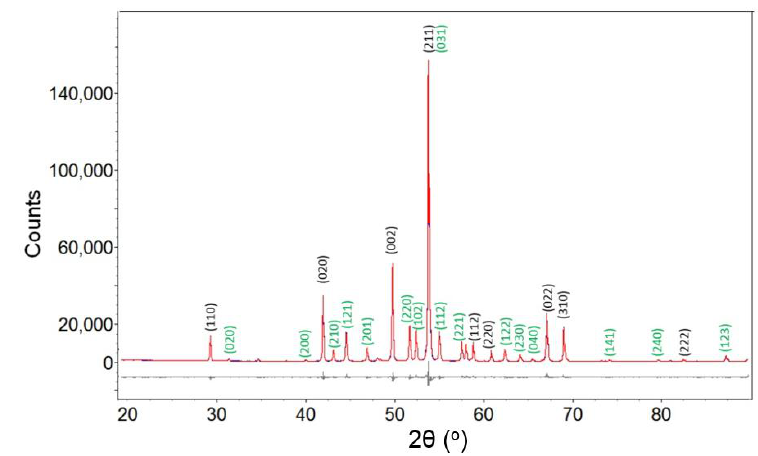
Figure 3. The experimental (blue), fitted (red) and difference (grey line below observed and calculated pattern) X-ray diffraction (XRD) profile for sample from Run 5. Indexed reflections for Ni 2 B and Ni 3 B are indexed with black and green color, respectively. Table 2. Rietveld refinement data for Ni 2 B and Ni 3 B from Run 5 and Run 9.